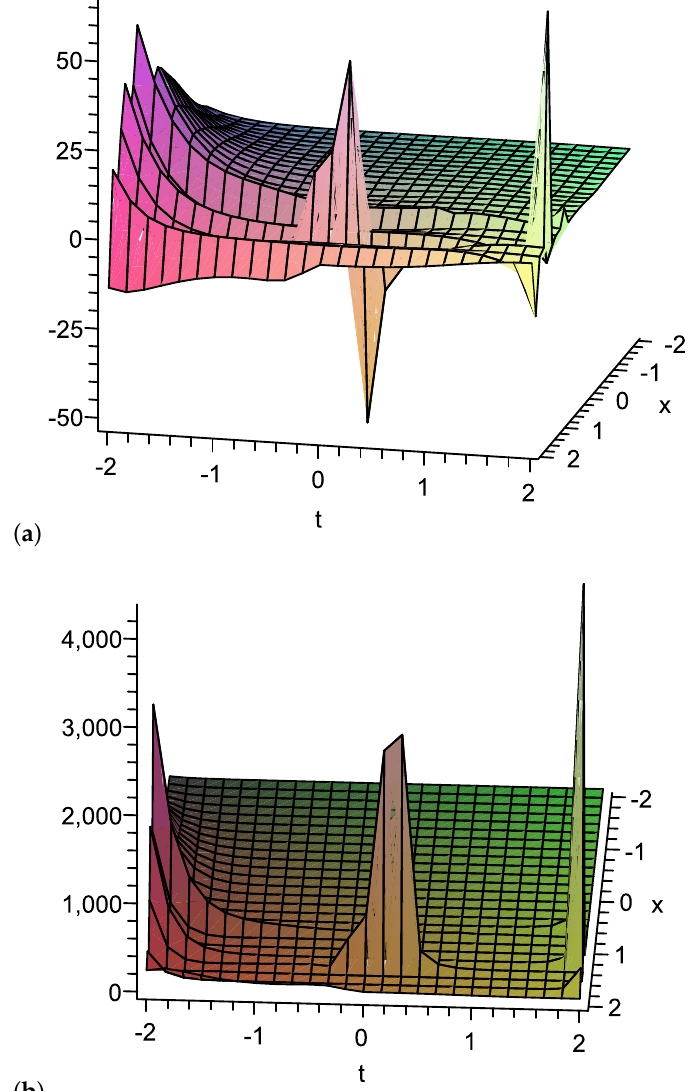
Figure 2. The first and second moments for the random solution sq 3 in (50); α is a beta distribution random variable and − 2 ≤ t , x ≤